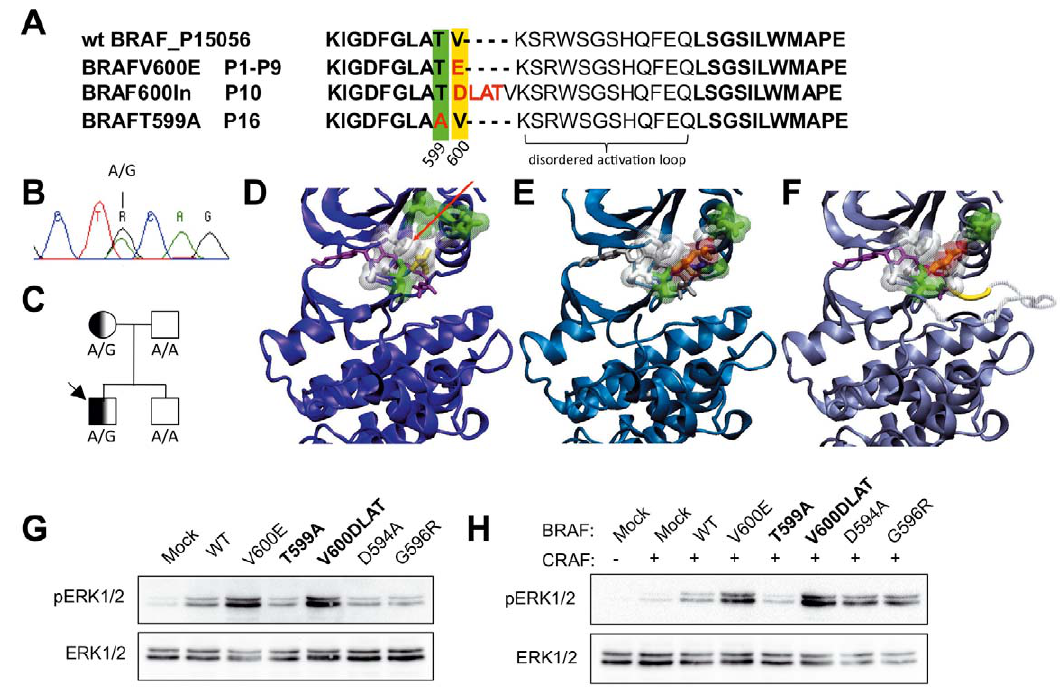
Figure 1. Analysis of B-RAF mutant. A. Sequence alignment, results from 454 pyrosequencing of granuloma cells from patients 1–10 and 16. B. ‘Sanger’ sequencing of patient 16 blood; A/G transition at nucleotide 1795. C. Pedigree of patient 16. Both the patient and his mother carry a T599A B- RAF allele, while his father is wt B-RAF. D–E. Comparison between wt B-RAF 5P_15056 (D, purple), V600E B-RAF structure (E, cyan) and the modeled mutant 600DLAT B-RAF (F, grey). In D, Val600 (yellow) forms a hydrophobic contact with Phe468 (red arrow). In E and F charged residues Asp and Glu (in orange) disrupt the hydrophobic network of interactions, stabilising the active conformation of the P-loop. In F, insertion Asp-Leu-Ala-Thr shifted Val600 and disrupt the hydrophobic cluster. G, H. MEK phosphorylation in 293 T cells. 293 T cells were transiently transfected with with mock or B- RAF mutant expressing vectors (WT, V600E, T599A, 600DLAT, D594A, G596R), and with (H) or without (G) wtC-RAF. Twenty-four hours after transfection, the medium was changed to serum-free DMEM, followed by further 18 hours culture. Total cell lysates were immunoblotted with the indicated antibodies.